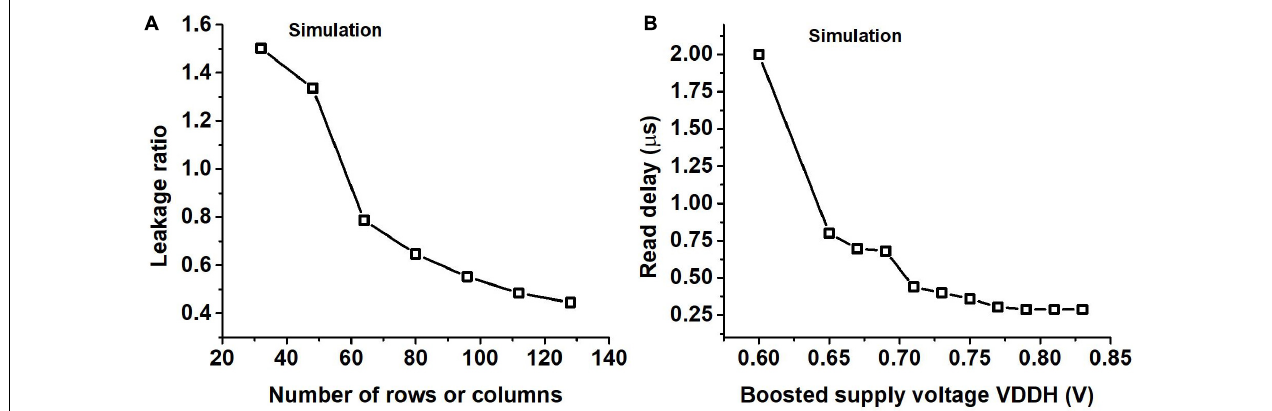
FIGURE 8 | (A) The ratio of the leakage of the peripheral circuits to that of the bitcells (leakage ratio) for different SRAM sizes where the number of rows is the same as the number of columns obtained using SPICE simulation. (B) Read delay of the SRAM for different boosted supply voltages (VDDH) obtained using SPICE